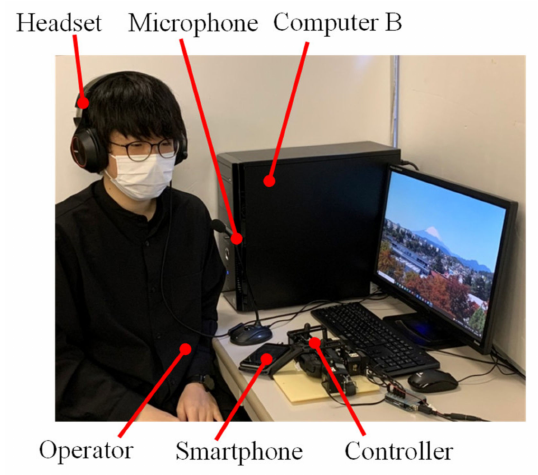
Figure 3. Operator (in Tokai University).